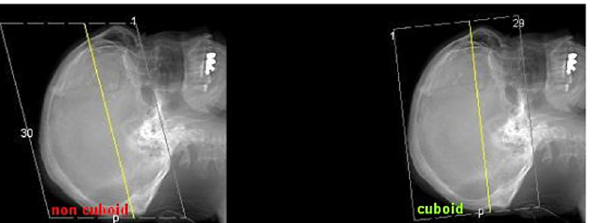
Fig 9. In order to be able to apply Pythagoras’ theorem, the line “travelled” by the cursor through the slices must be vertical to the slice orientation. This is only the case if the slices are “piled aligned” in a cuboid dataset ( right ). If the gantry angle is modified during data acquisition, the resulting dataset is a non-cuboid parallelepiped, and the calculation cannot be applied. In that case, a cuboid dataset can be reconstructed at the CT workstation. Whether the regarded slices are applicable for the caliper navigation technique or not can be seen at a glance in the corresponding scout.